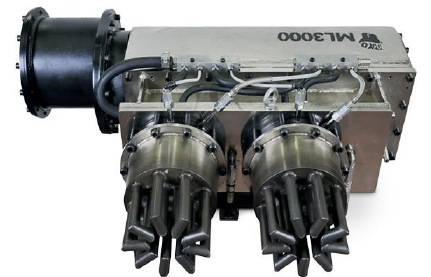
Fig. 1. Two-cylinder Stirling engine Genoa, ML3000, power 3 kWe [13]